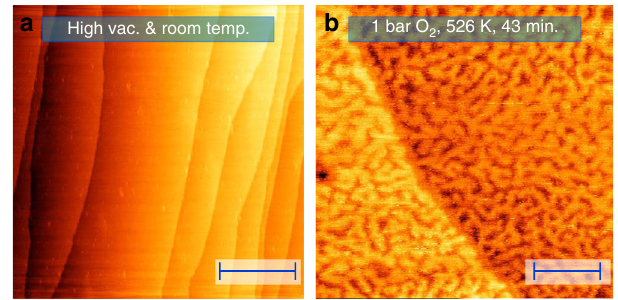
Fig. 2 Larger-scale structure of the surface oxide. STM images showing the change in large-scale morphology upon high-pressure O 2 exposure. Freshly prepared Pt(111) surface ( a ) in the reactor (high vacuum at room temperature); stable, oxidized surface ( b ) at 1.0 bar O 2 and 531 K after 43 min exposure to these conditions. Nonlinear fi ltering was applied to remove artifacts due to vibrational interference of the microscope. Scale bars represent 100 nm ( a ) and 20 nm (